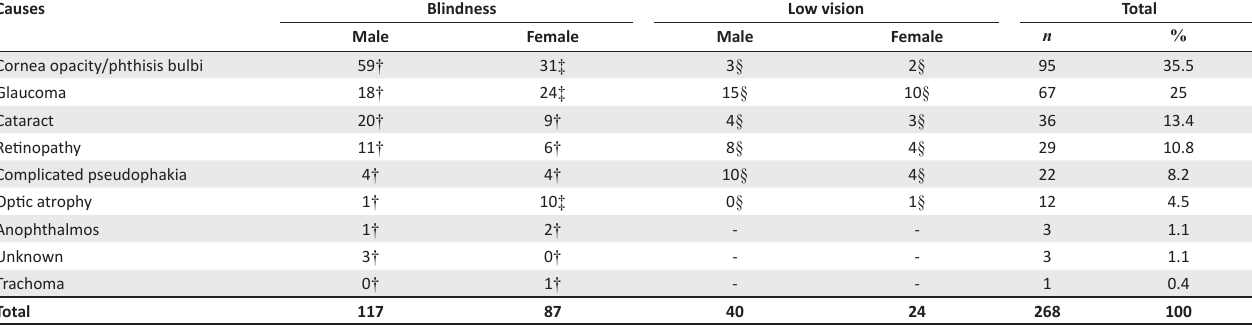
TABLE 6: Association between the proportion of gender and causes of low vision and blindness. Causes